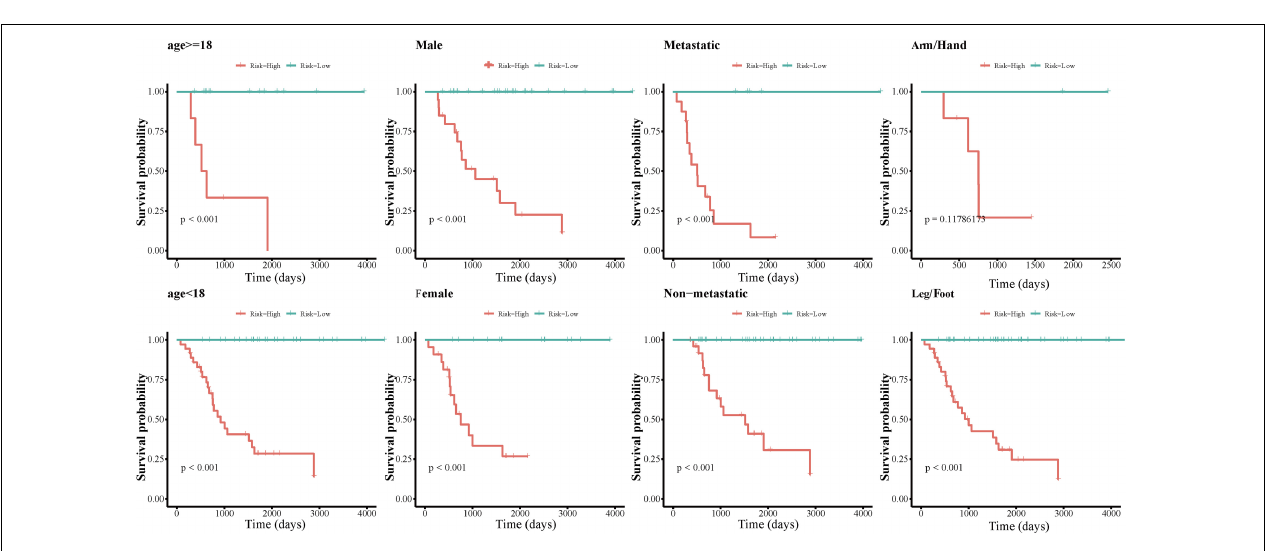
FIGURE 7 | Kaplan-Meier survival analyses of the autophagy-related lncRNA signature in different osteosarcoma patient